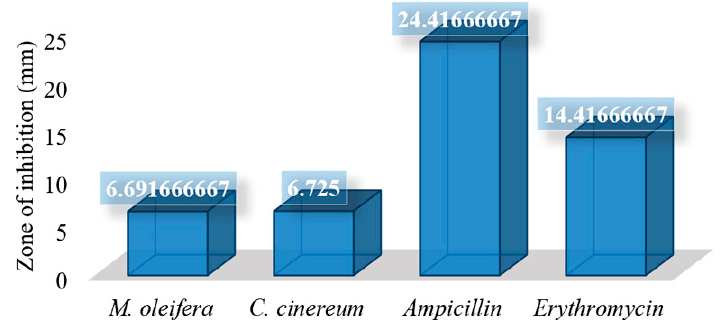
Fig. 9. Difference in zone of inhibition for natural and synthetic antibiotics against K.